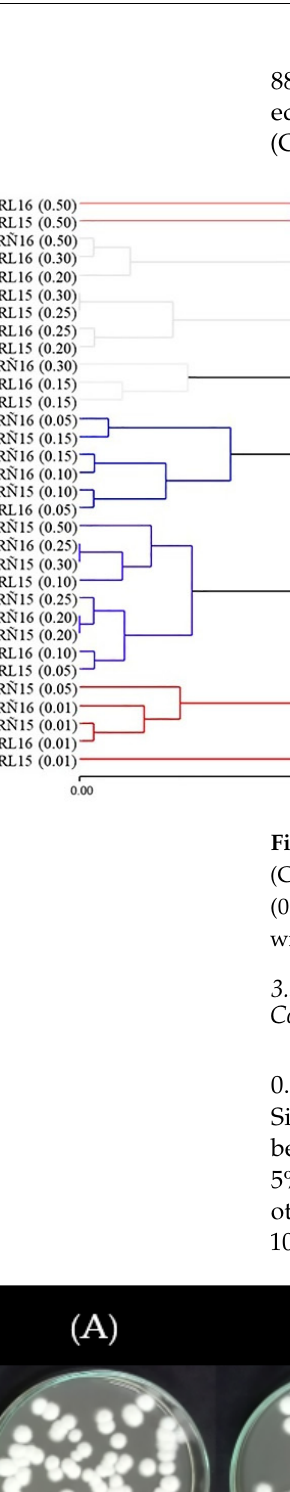
9 of 15 Figure 4. Disease severity of Chilean CP13 isolate of Phlyctema vagabunda in ‘Cripps Pink’ apples inoculated with sterile distilled water ( A ), mycelium disc ( B ), and conidia suspension ( C ). The fruit was incubated at 20 °C for 20 days. 3.4. Effect of Propolis Extracts on the Mycelial Growth of Phlyctema Vagabunda Since CP13 resulted in the most aggressive isolate in apple fruits (Figure 5), propolis methanolic extracts were tested for their effects on the mycelial growth of this isolate. The propolis extracts at different concentrations could be grouped into four clusters (CC =